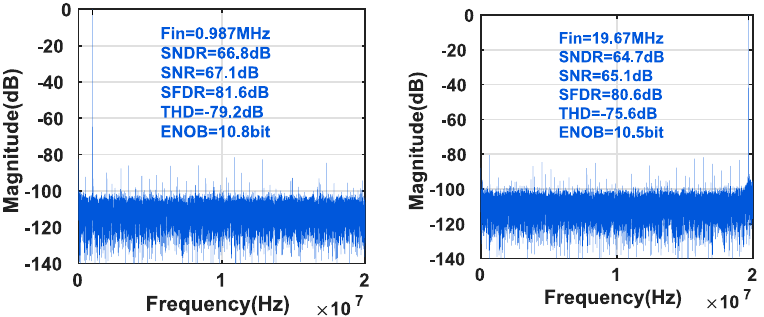
Figure 18. The measured frequency spectrum of the SAR ADC with the SCRD at near 1 MHz and 20 MHz input frequency.